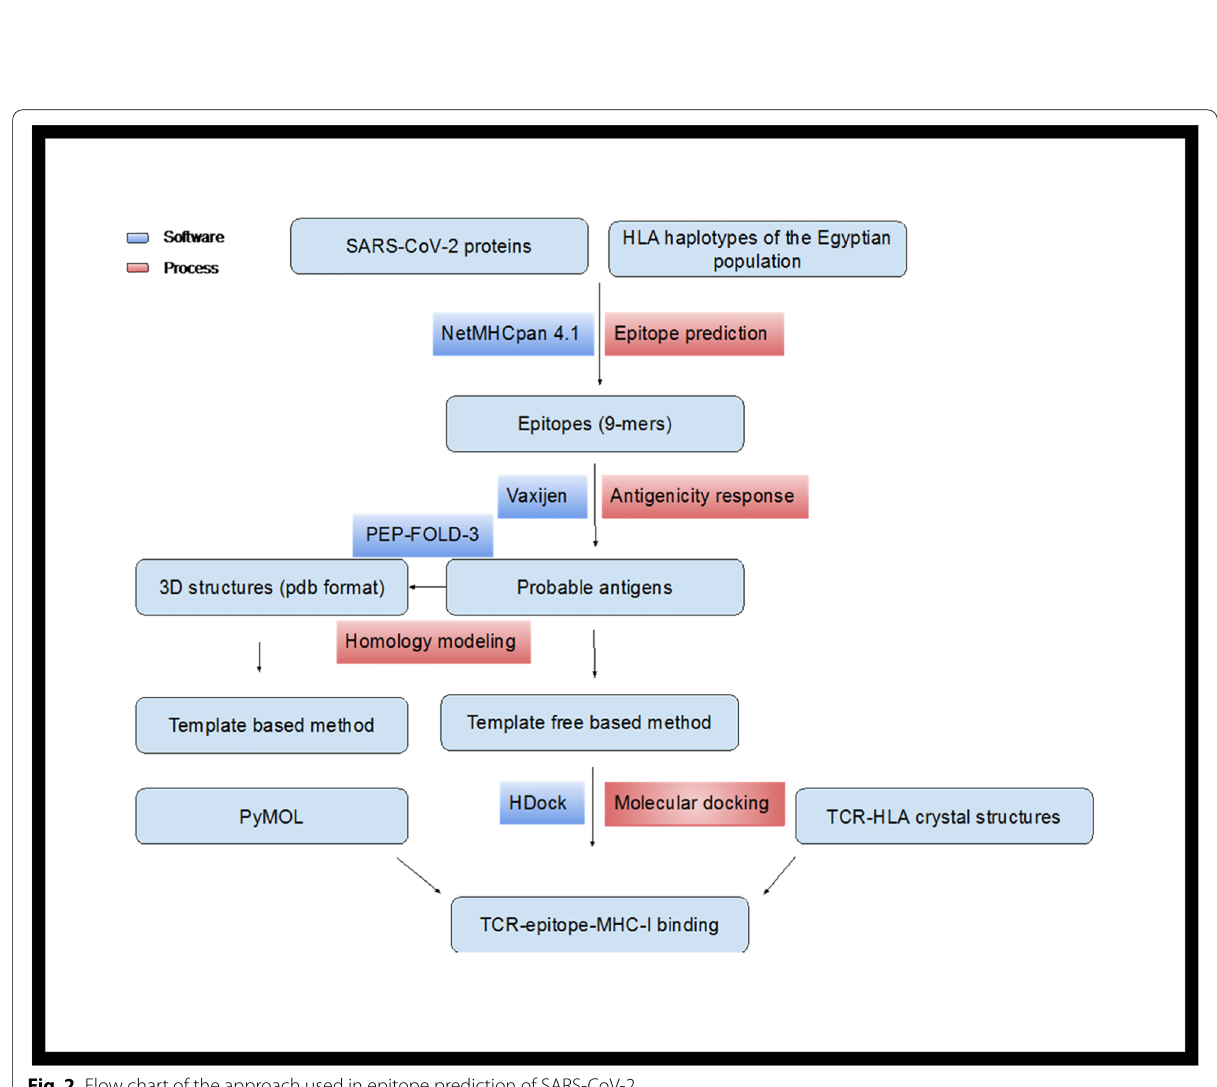
Fig. 2 Flow chart of the approach used in epitope prediction of